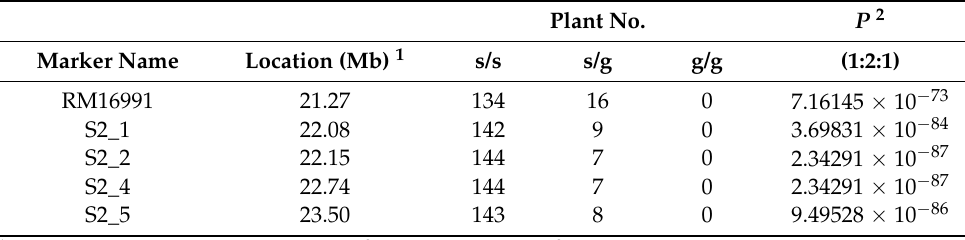
Table 1. Segregation distortion observed in the F 2 population derived from the cross between W025 and W025S2s.